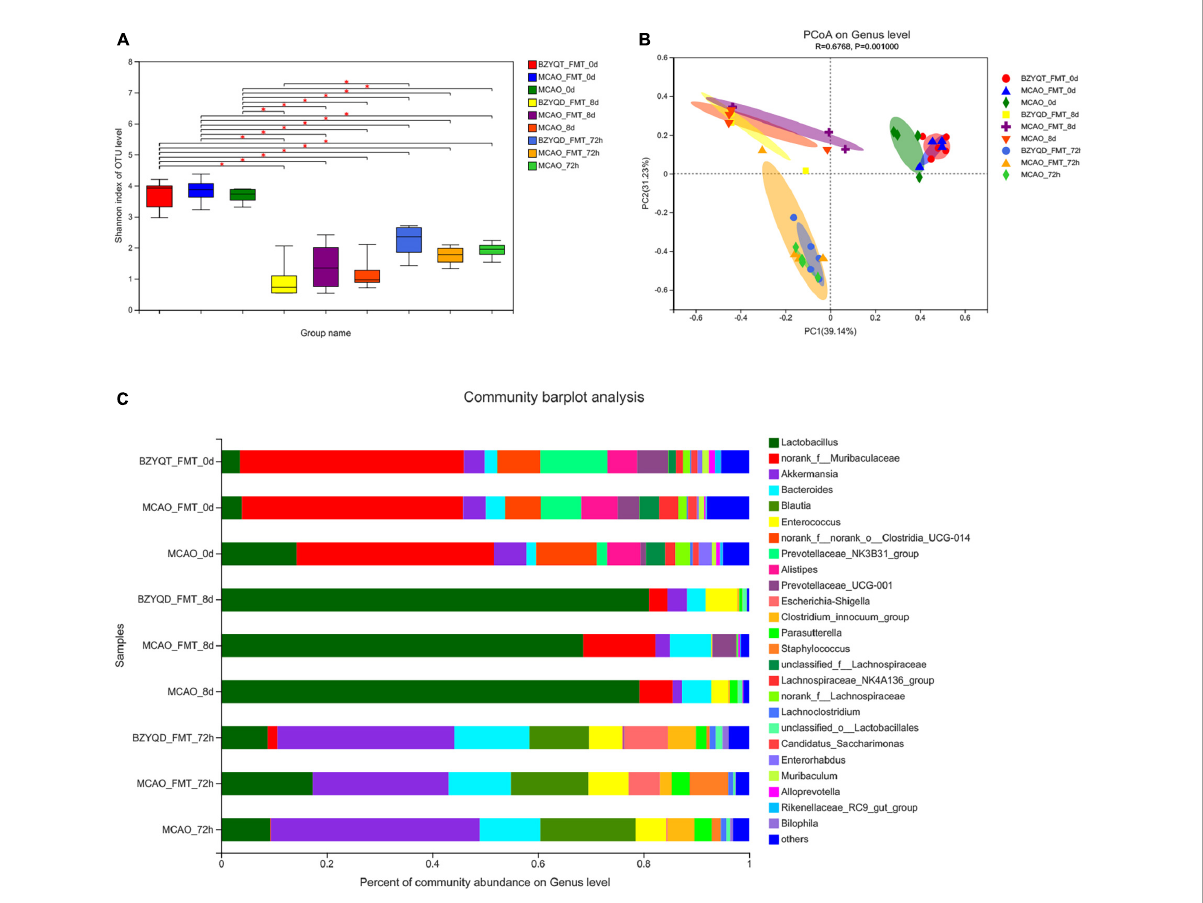
FIGURE5 The effect of each node operation on the intestinal flora of mice in the microbiota transplantation stage. Intestinal microflora α Diversity (A) is the Shannon index; (B) is the PCoA analysis; (C) is the species composition at the genus level at each time point in the fecal transplantation stage. * p < 0.05. Data are expressed as mean ± standard deviation. n =